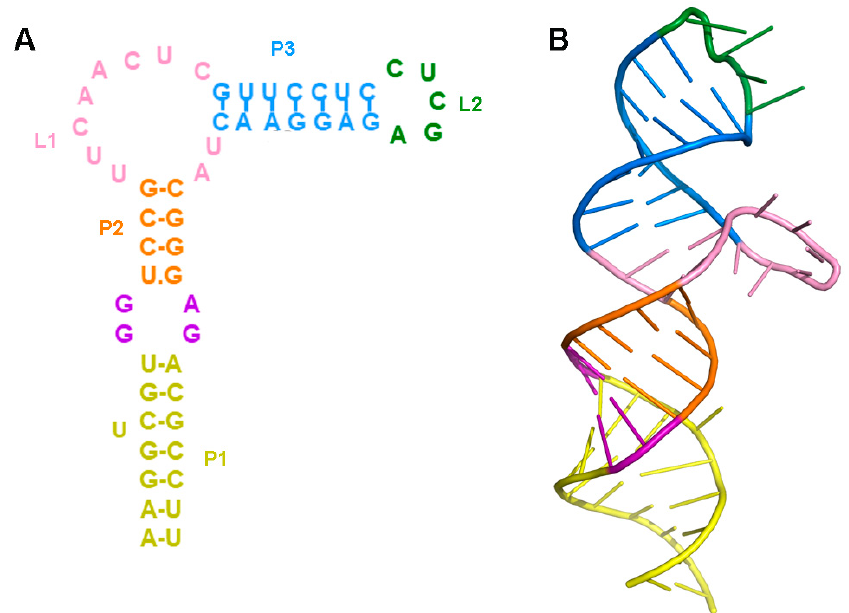
Figure 1. Prediction of the three-dimensional structure of the THF-II riboswitch. ( A ) Sequence and secondary structure prediction of the THF-II riboswitch. ( B ) 3D predicted structure of the THF-II riboswitch. The GGAG-connected P1 and P2 are shown in purple. The Loop1 and Loop2 residues are shown in pink and green. The P1, P2 and P3 stems of the RNA are labeled in dark khaki, orange and blue, respectively.